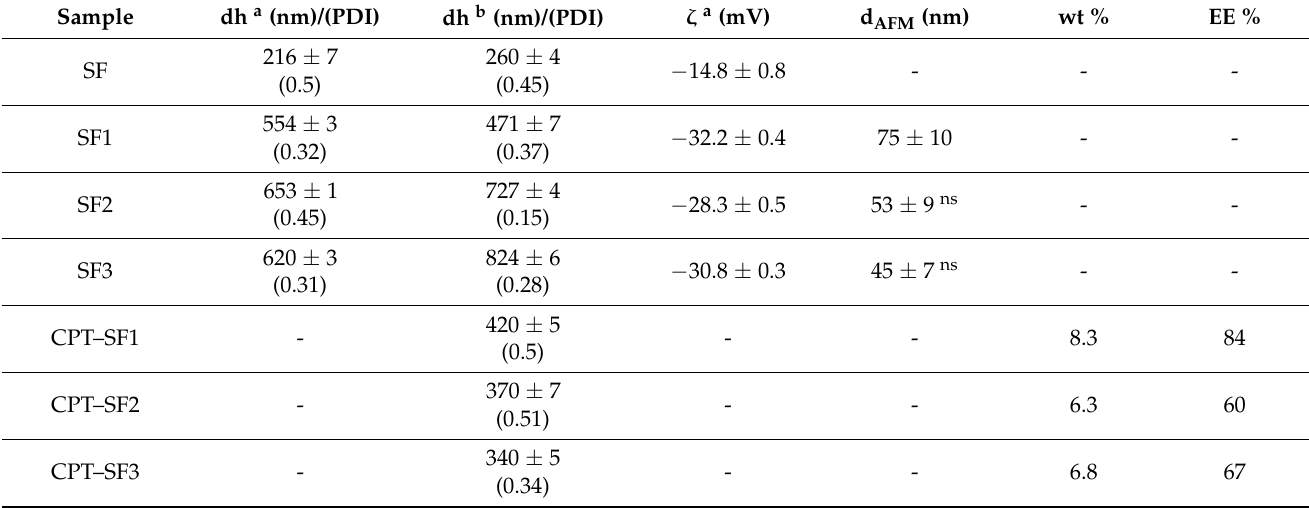
Table 2. Hydrodynamic parameters of SF aggregates; AFM average diameters of raw and modified SF dried particles; CPT contents in weight (wt %) and CPT encapsulation efficiency (EE %) of CPT-loaded SF aggregates.